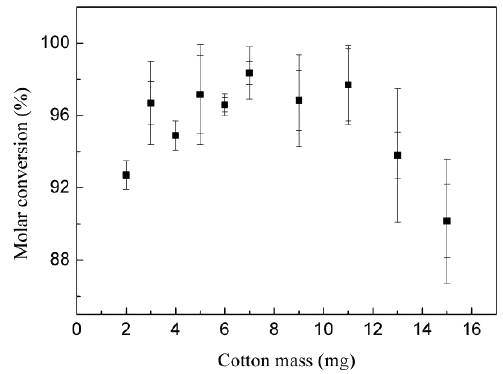
Figure 2: Kinetics of cotton-PCL, LDVB-PCL, PDVB-PCL and PC-18- PCL in which PCL is 1 mg.